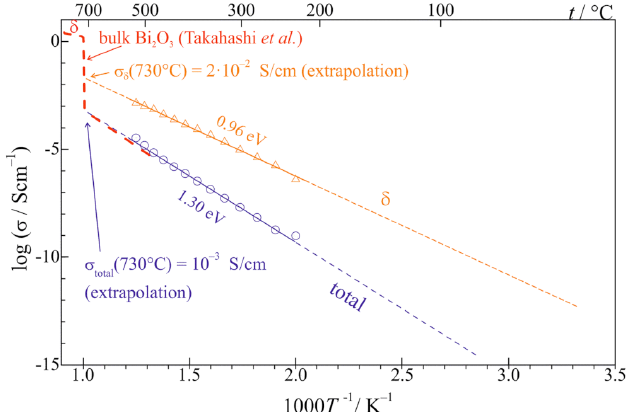
Figure 18. Temperature dependence of conductivity of a glass-ceramic Bi 2 O 3 sample: total conduc- tivity (circles), conductivity of the δ -like phase determined from analyses of the impedance spectra (triangles) together with the respective fits (straight lines). The data for the high temperature δ phase of bulk Bi 2 O 3 (red dashed line) (after Takahashi et al. [84]) are included for comparison. (Reproduced with permission from ref. [79]. Copyright 2018,